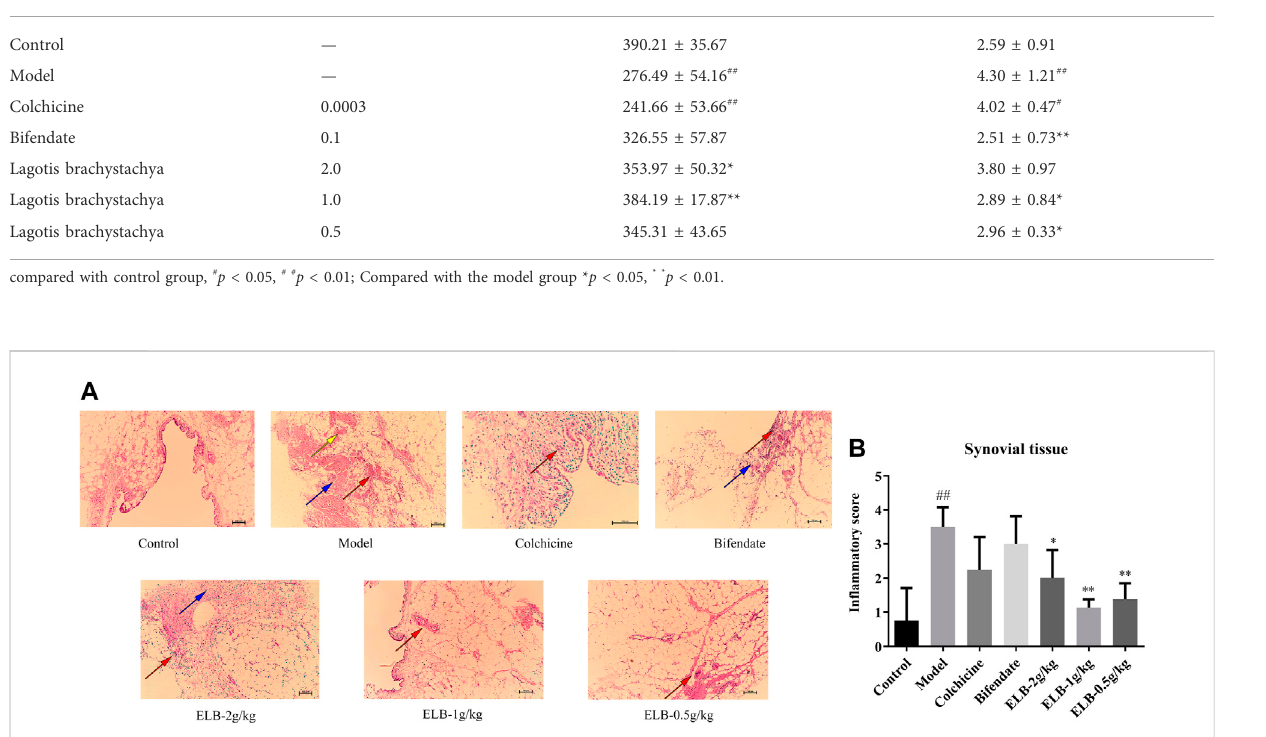
TABLE 4 Effects of total extract of Lagotis brachystachya on the contents of SOD and MDA in the liver homogenate of the rat model with chronic alcoholic liver injury and gouty arthritis (x ± s , n = 8). Group